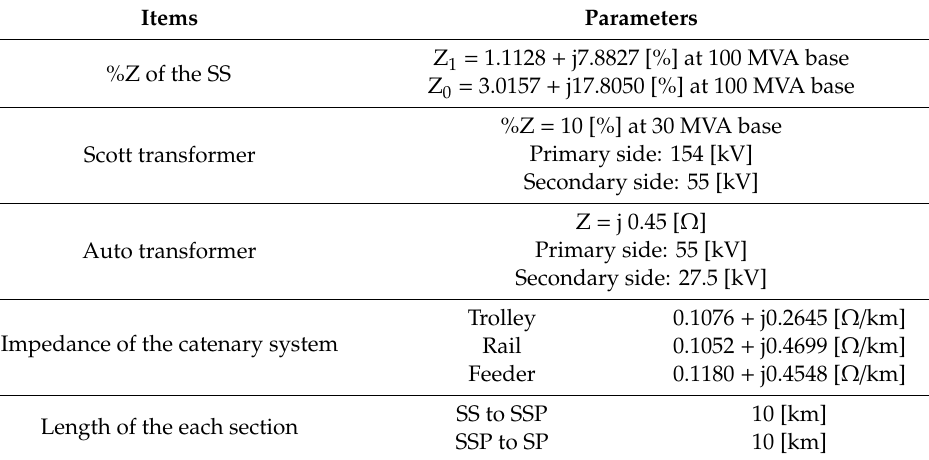
Figure 12. TPSS for case studies. Table 5. Parameters of the traction power-supply system (TPSS)